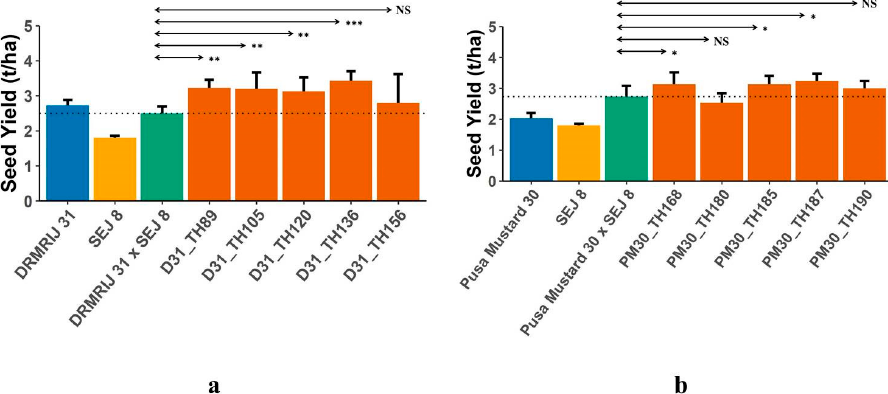
Figure 2. ( a ) Mean seed yield of test hybrids (D31_THs) developed using introgression lines of DRMRIJ 31 (D31_ILs) and common tester (SEJ 8) in comparison to check hybrid (DRMRIJ 31 x SEJ 8) and parents; ( b ) Mean seed yield of test hybrids (PM30_THs) developed using introgression lines of Pusa Mustard 30 (PM30_ILs) and common tester (SEJ 8) in comparison with check hybrid (Pusa Mustard 30 x SEJ 8) and parents (* signi fi cant at p = 0.1; ** signi fi cant at p = 0.05; *** signi fi cant at p = 0.01; NS = Non Signi fi cant).